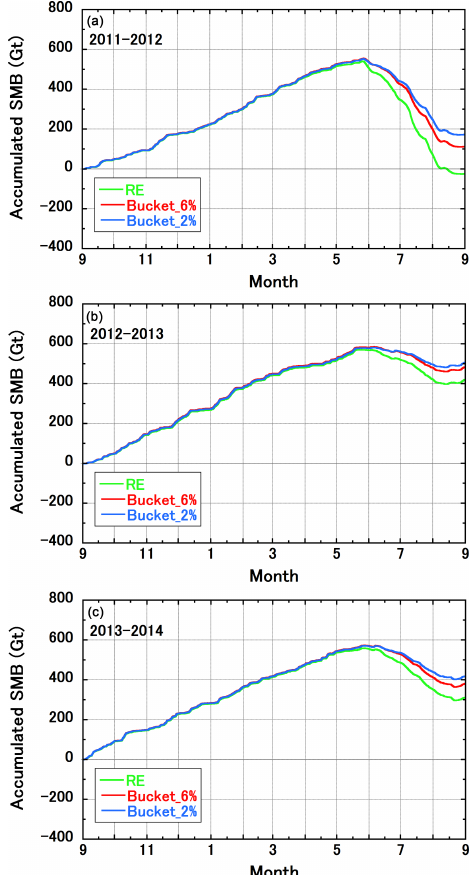
Figure 11. Sensitivity to the choice of vertical water movement scheme of the simulated SMB for the GrIS during the (a) 2011– 2012, (b) 2012–2013, and (c) 2013–2014 mass balance years. RE indicates the default setting for vertical water movement in snow and firn based on the Richards equation; Bucket_6% and Bucket_2% are alternative settings based on simple bucket schemes with irreducible water contents of 6 and 2% of the pore